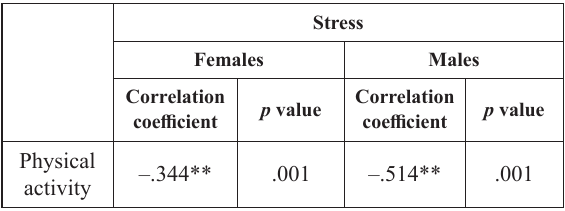
Table 1. Interrelationship between perceived stress and physical activity among